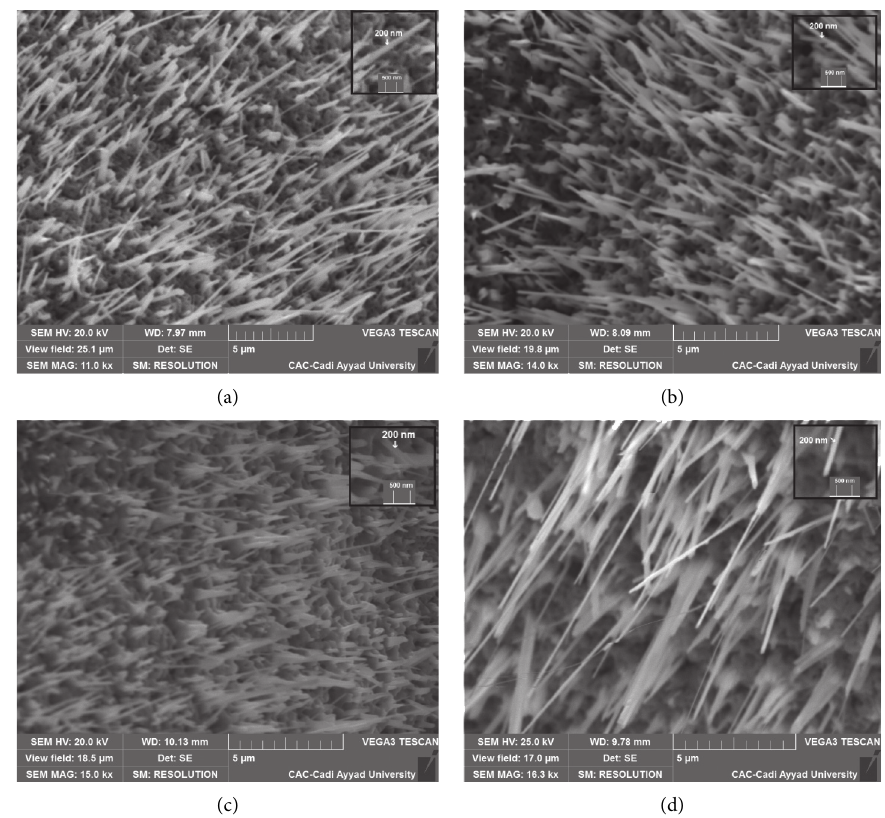
Figure 1: SEM images for CuO NWs obtained by thermal oxidation of copper foils at 550 ° C for 4h The heating rates are (a) 1 ° C/min; (b) 2 ° C/min; (c) 5 ° C/min; and (d) 10 ° C/min. While the diameter is almost the same in all samples, the NW density slightly decreases with increasing the heating Table 1: NWs density estimated by the SEM images and crystallite size calculated using the Scherrer equation for various heating rates. Heating rate ( ° C/min)